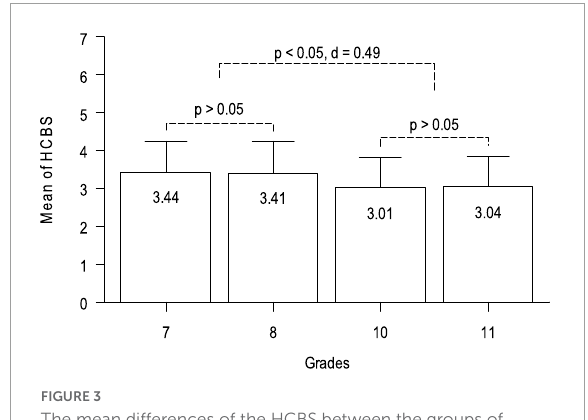
FIGURE3 The mean differences of the HCBS between the groups of